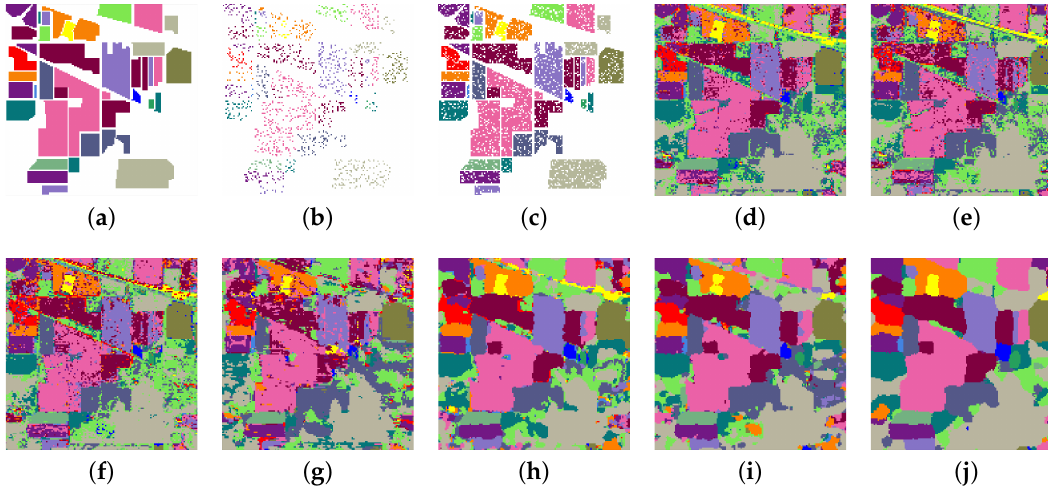
Figure 7. Classification maps for the Indian Pines data set. ( a ) Ground-truth. ( b ) Training set. ( c ) Testing set. Classification maps by: ( d ) SVM (83.77%); ( e ) RF (78.41%); (f) MLP (83.02%); ( g ) 2D-CNN (82.35%);